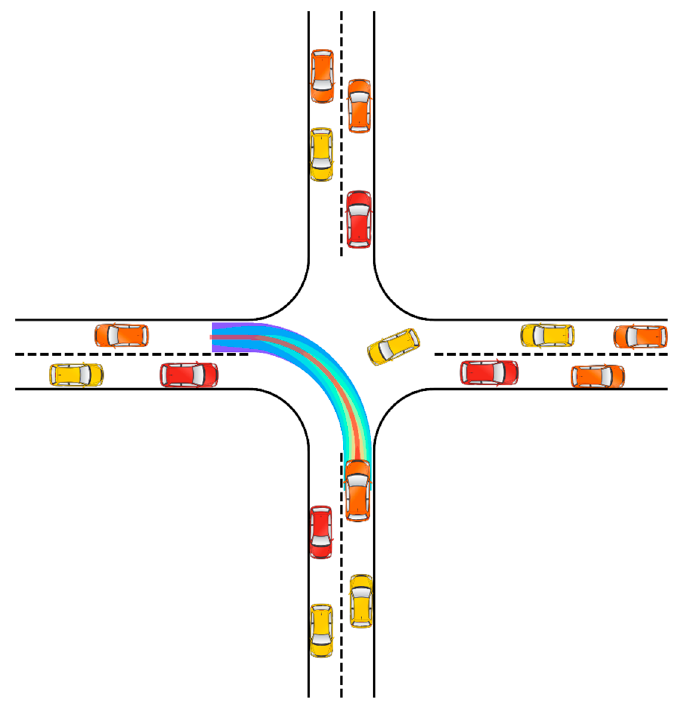
Figure 5. The highway environment.